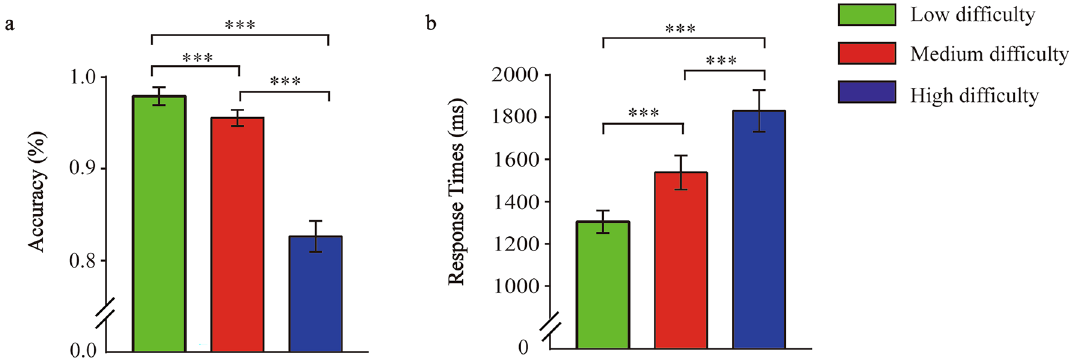
Figure 1. Performance during the active trials. ( A ) Bar plots of accuracy according to the level of difficulty. ( B ) Bar plots of reaction times according to the level of difficulty. Participants were indeed able to discriminate dominant from submissive faces (chance level of accuracy 50%). Error bars indicate standard error of mean (SE), (* p < 0.05, ** p < 0.01, *** p <